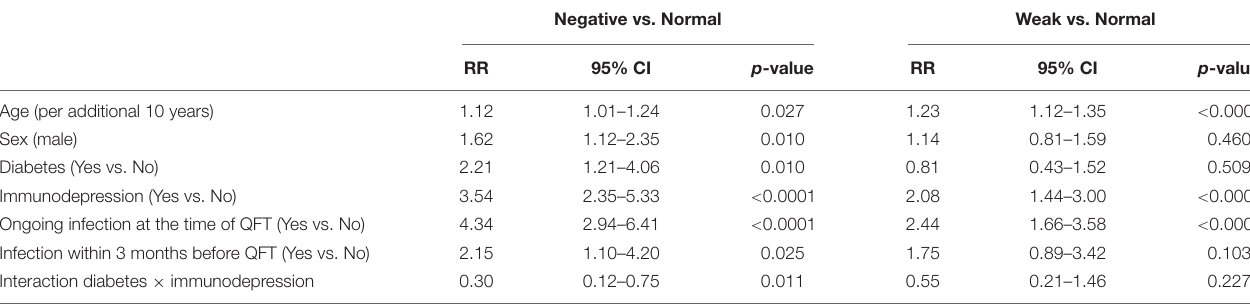
TABLE 2 | Multinomial logistic regression for clinical factors associated with a “negative” and “weak” mitogen response on QFT test (Model 1). Negative vs. Normal Weak vs.